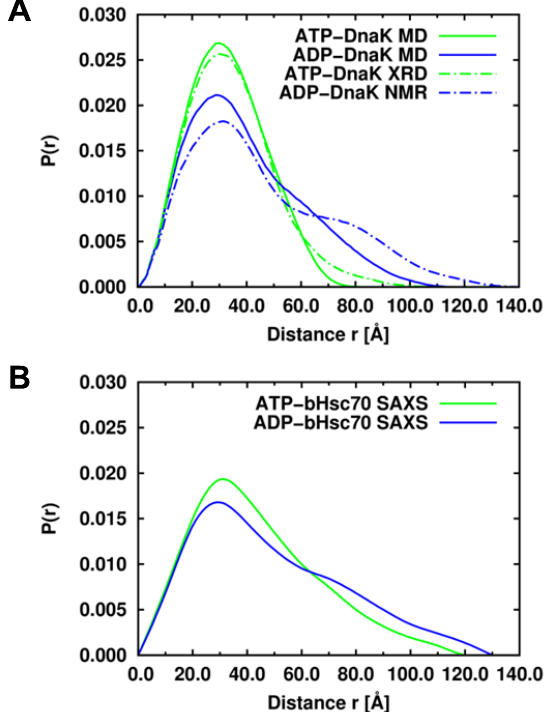
Figure 3. Comparison between the simulated and experimen- tal distance distribution functions P(r) of Hsp70 s. A: Distance distribution function P(r) of the ATP-bound (green lines) and ADP- bound (blue lines) of E. coli DnaK computed from MD simulations (solid lines) and computed from the experimental X-ray (PDB ID: 4BQ9) [69] and NMR-derived (PDB ID: 2KHO) [70] structures (dashed lines), respectively. B: Distance distribution function P(r) of the ATP-bound (green line) and ADP-bound (blue line) of bHsc70. The function P(r) of bHsc70 in the ATP and ADP states were digitized from Figure 4 of Ref. [82].